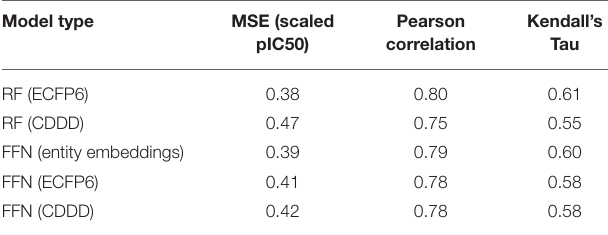
TABLE 1 | ChEMBL25 validation set performance metrics for both the RF and FFN models as well as the SMILES featurization method used.